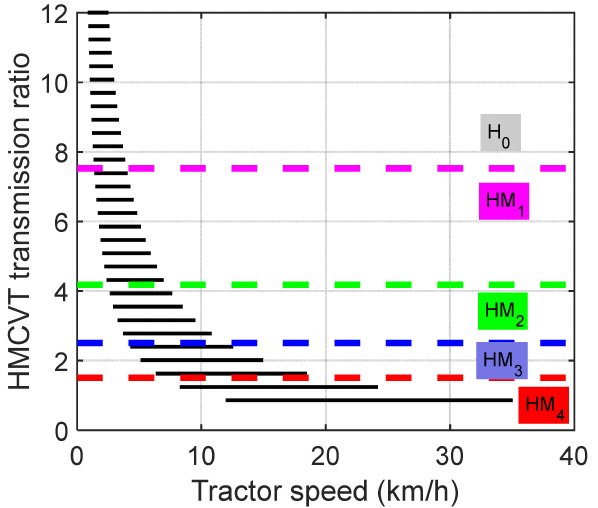
Figure 6. The variation range of target transmission ratio and its corresponding relationship with tractor